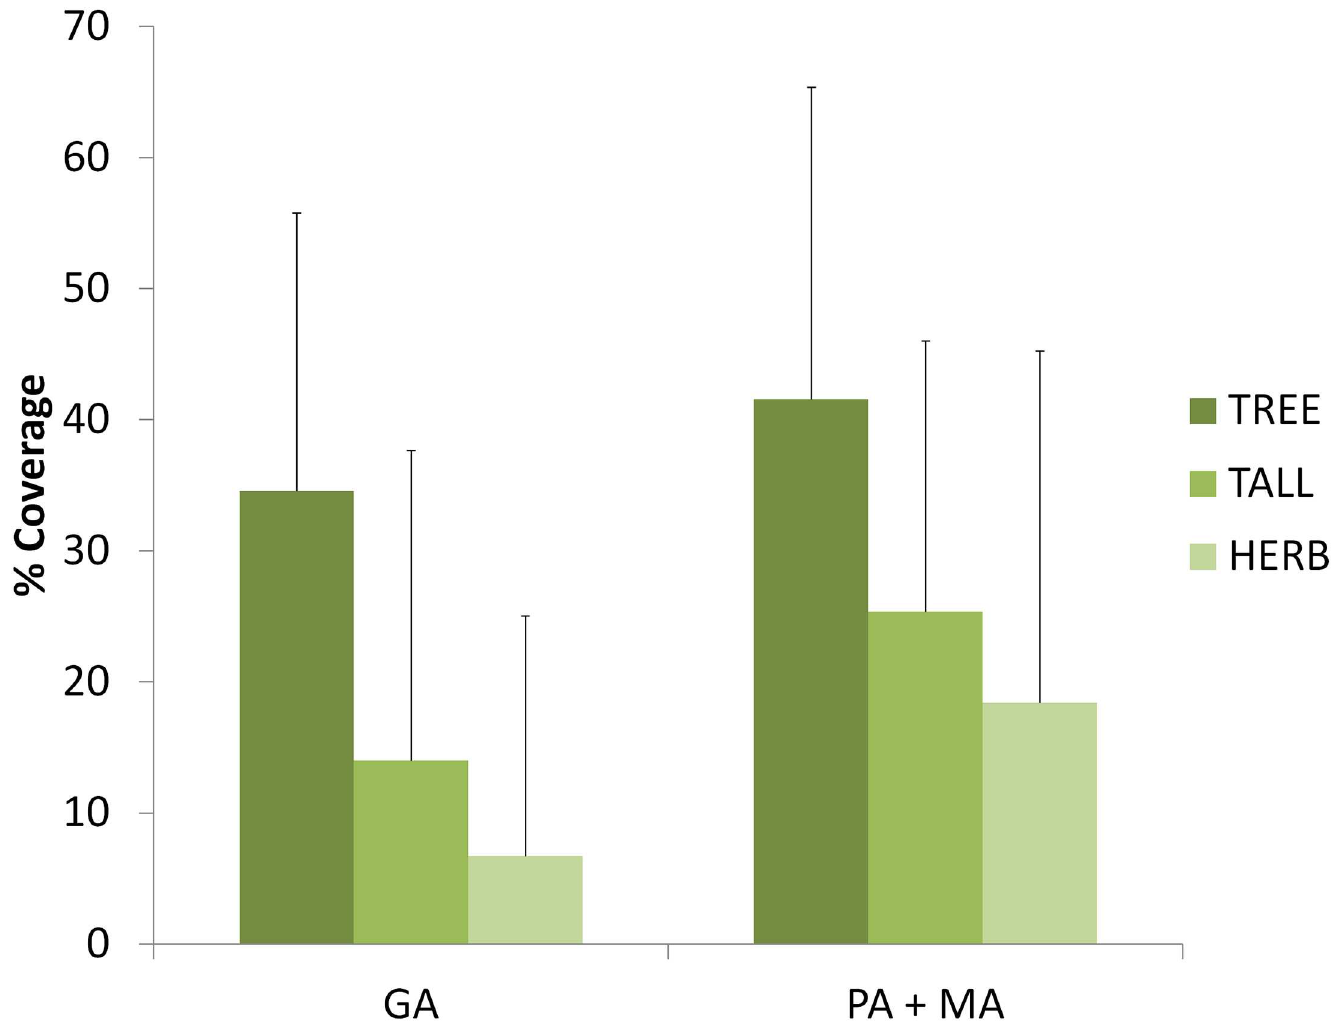
Fig 4. Comparison of microhabitat characteristics of pine forests between patches with high and low density of tortoises. MA and PA show lower density than site GA and thus are merged. See Table 1 for categories of vegetationcover.